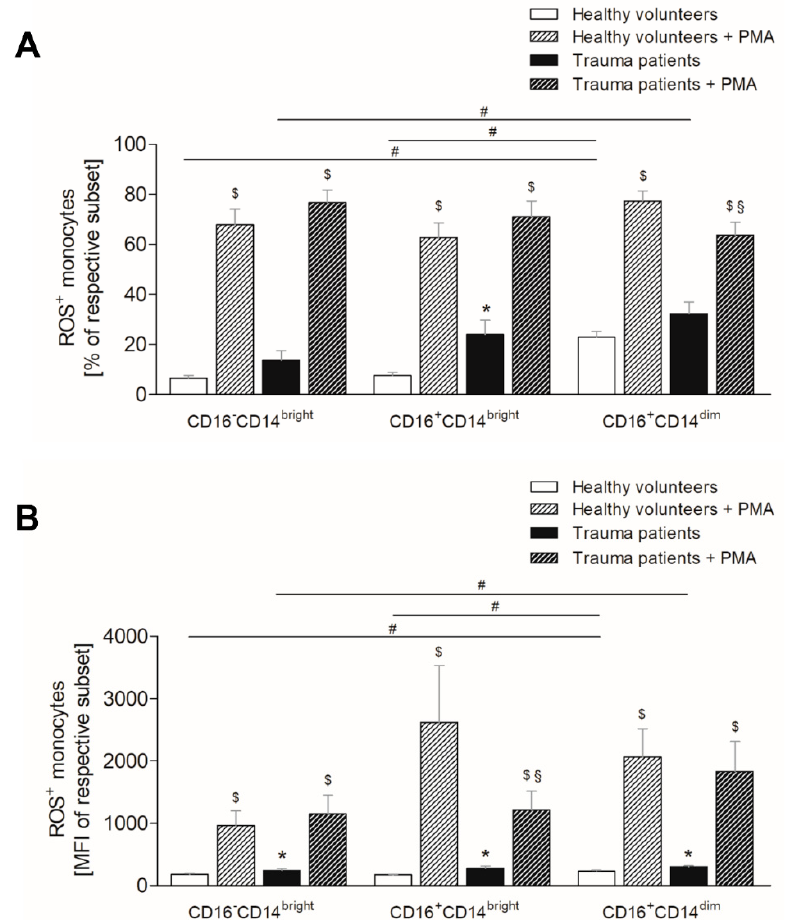
Figure 5. Impact of severe traumatic injury on generation of reactive oxygen species (ROS) by monocyte subsets. The ( A ) percentage and ( B ) mean intensity of ROS positive CD14brightCD16 − (classical), CD14 bright CD16 + (intermediate) and CD14 dim CD16 + (non-classical) monocytes were determined in healthy subjects (white bars) and severely injured patients (black bars) within 12 h postinjury. Whole blood was stimulated with PMA ex vivo (diagonally striped bars). Data are presented as mean ± standard error of the mean. *: p < 0.05 vs. healthy volunteers; #: p < 0.05 vs. respective subset; $: p < 0.05 vs. unstimulated corresponding subset; §: p < 0.05 vs. healthy volunteers + PMA.